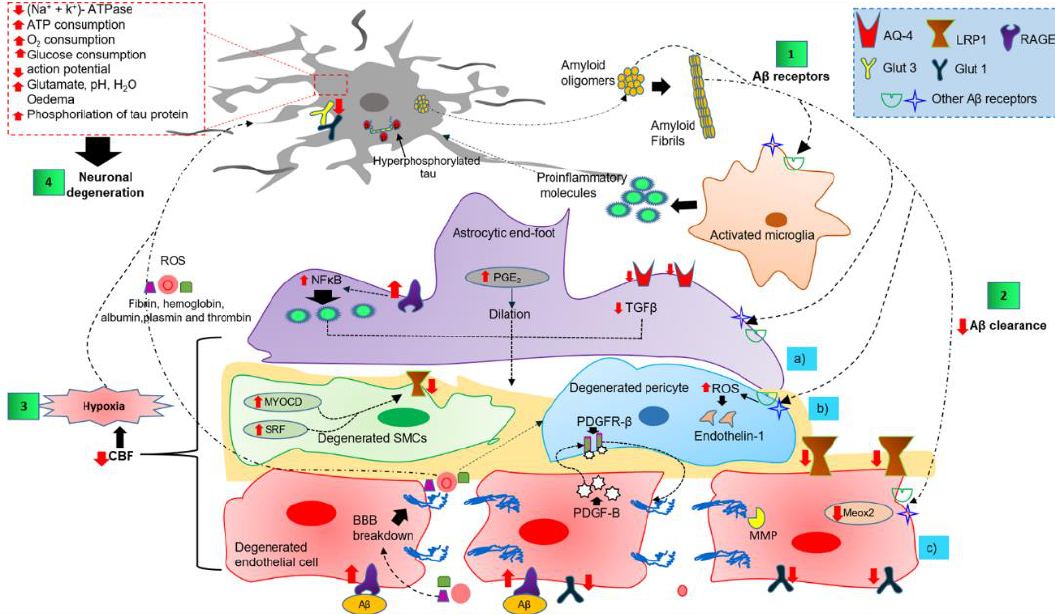
Figure 3. Overview of the complex cell–cell signaling in the NVU, triggered by extracellular and vascular Aβ deposits. Step 1 shows the interaction of Aβ oligomers and fibrils with NVU cells through several receptors. Step 2 illustrates the altered Aβ clearance that triggers NVU dysfunction. Step 3 shows the NVU cell dysfunction as the causative agent of cerebral hypoxia. Step 4 shows cerebral hypoxia, neuroinflammatory environment, and peripheral blood infiltrate as the promoting causes of neuronal degeneration. Abbreviations: AQ-4, aquaporin-4; Aβ, amyloid peptide; BBB, blood-brain barrier; CBF, cerebral blood flow; GLUT, glucose transporter; LRP1, low-density lipoprotein receptor-related protein 1; MEOX2, mesenchyme homeobox 2; MMP, matrix metalloproteinase; MYOCD, myocardin; NFκB, nuclear factor kappa light chain enhancer of activated B cells; PDGF-B, platelet-derived growth factor subunit B; PDGFRβ, platelet-derived growth factor receptor β; PGE 2 , prostaglandin E2; TGFβ, transforming growth factor-beta; RAGE, receptor for advanced glycation end products; ROS, reactive oxygen species. Table 1. Interaction among different species of Aβ aggregates (f: fibrillar; o: oligomeric; m: monomeric; *: unknown), re- ceptors in NVU cells, and pathological effects. Pathological Effects Ref.